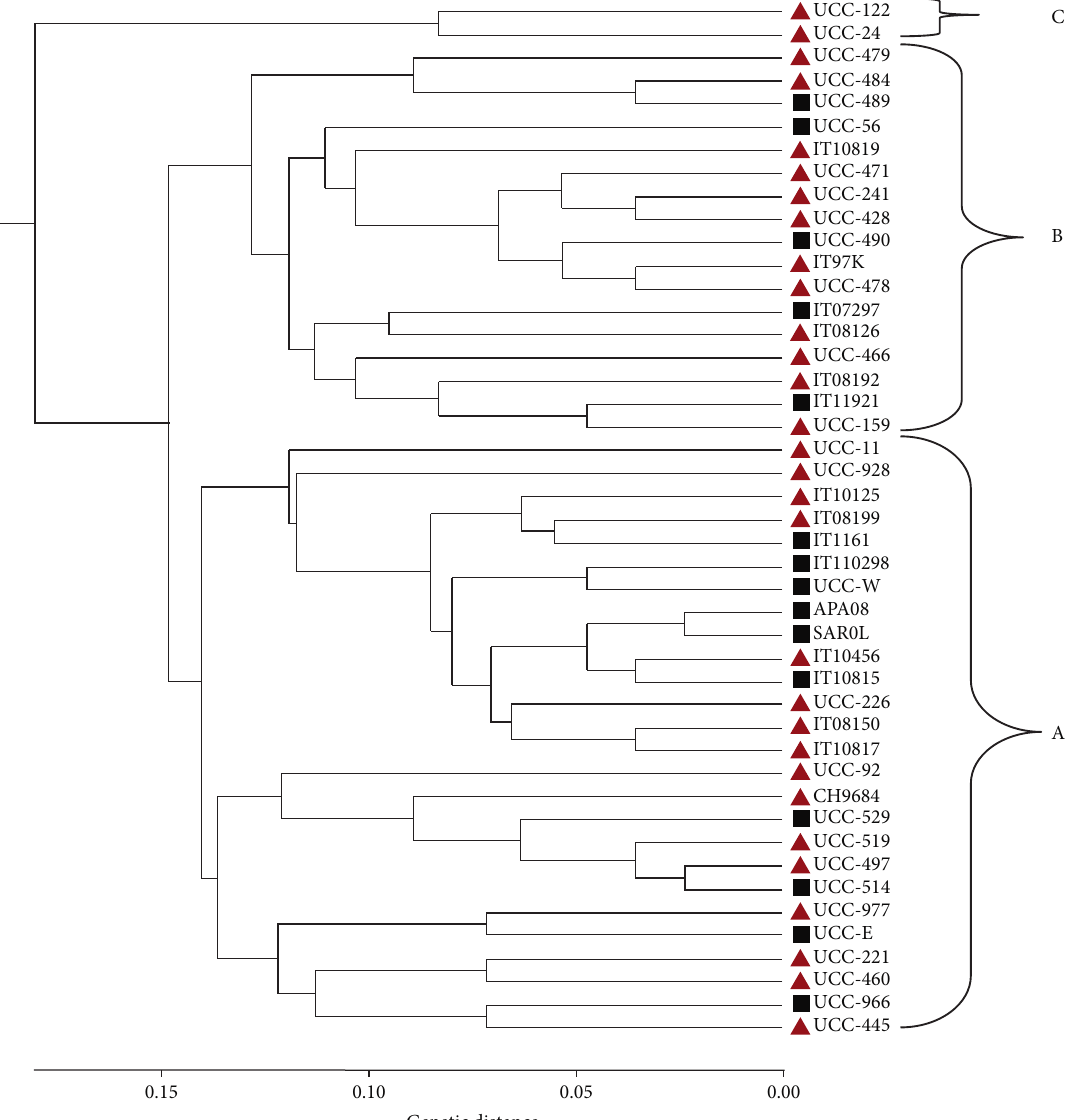
Figure 2: Phylogenetic relationship among 46 cowpea genotypes. A dendrogram was generated using sixteen informative SSR markers and sequential clustering algorithm (UPGMA) based on genetic similarity. UCC − E � UCC − Early; UCC − W � UCC − White; APAGB � Apagbaala; SARCL � SARC − LO2; IT97K � IT97K − 499-35; � Striga -resistant; and ■ � Striga